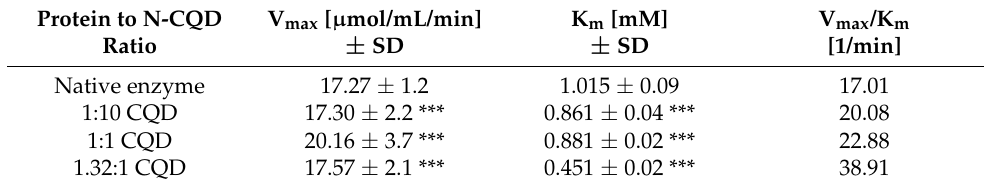
Table 3. Kinetic parameters of native and immobilized β -D-galactosidase. The statistical significance of the differences between native and immobilized enzyme is marked with asterisks (*** for p ≤ 0.001). Protein to